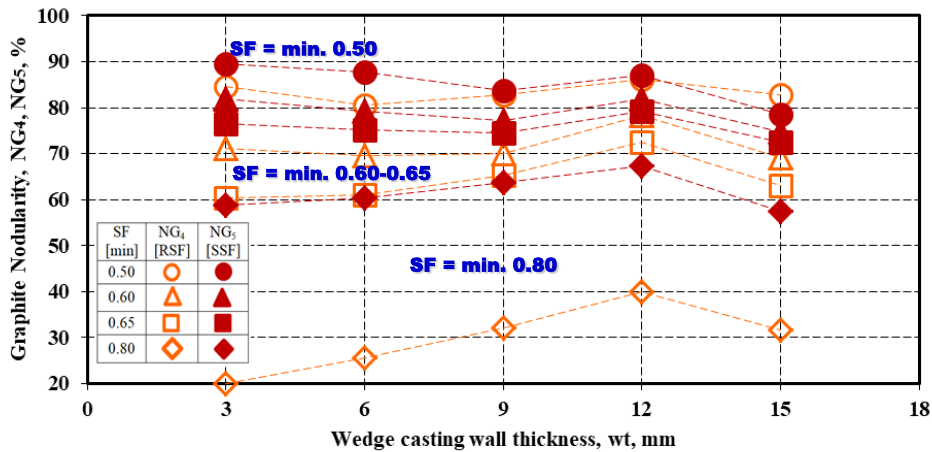
Figure 11. Graphite nodularity NG 4 [RSF] and NG 5 [SSF] for the minimum imposed values for Graphite Shape Factors (SF), RSF, and SSF.